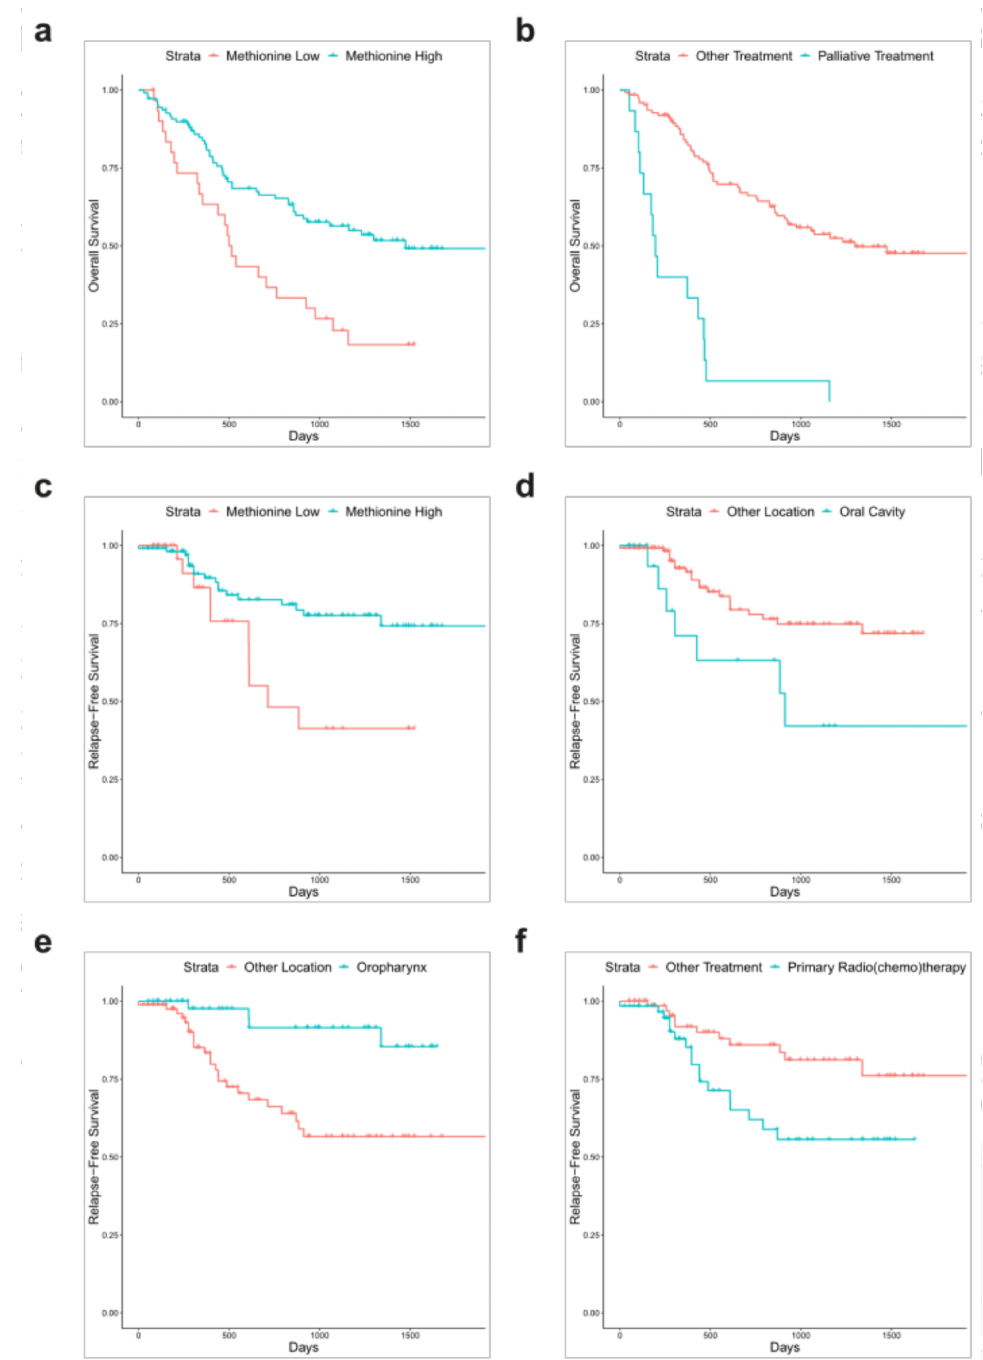
Figure 1. Kaplan-Meier plots for 5-year overall survival (OS) and relapse-free survival (RFS) stratified by statistically significant factors in the multivariate regression analysis: Serum concentration of methionine and overall survival (OS) ( a ), palliative treatment and OS ( b ), serum concentration of methionine and relapse-free survival (RFS) ( c ), oral cavity location and RFS ( d ), oropharyngeal location and RFS ( e ) and primary radio(chemo)therapy treatment and RFS ( f ). Data for statistically insignificant factors in the multivariable model are not